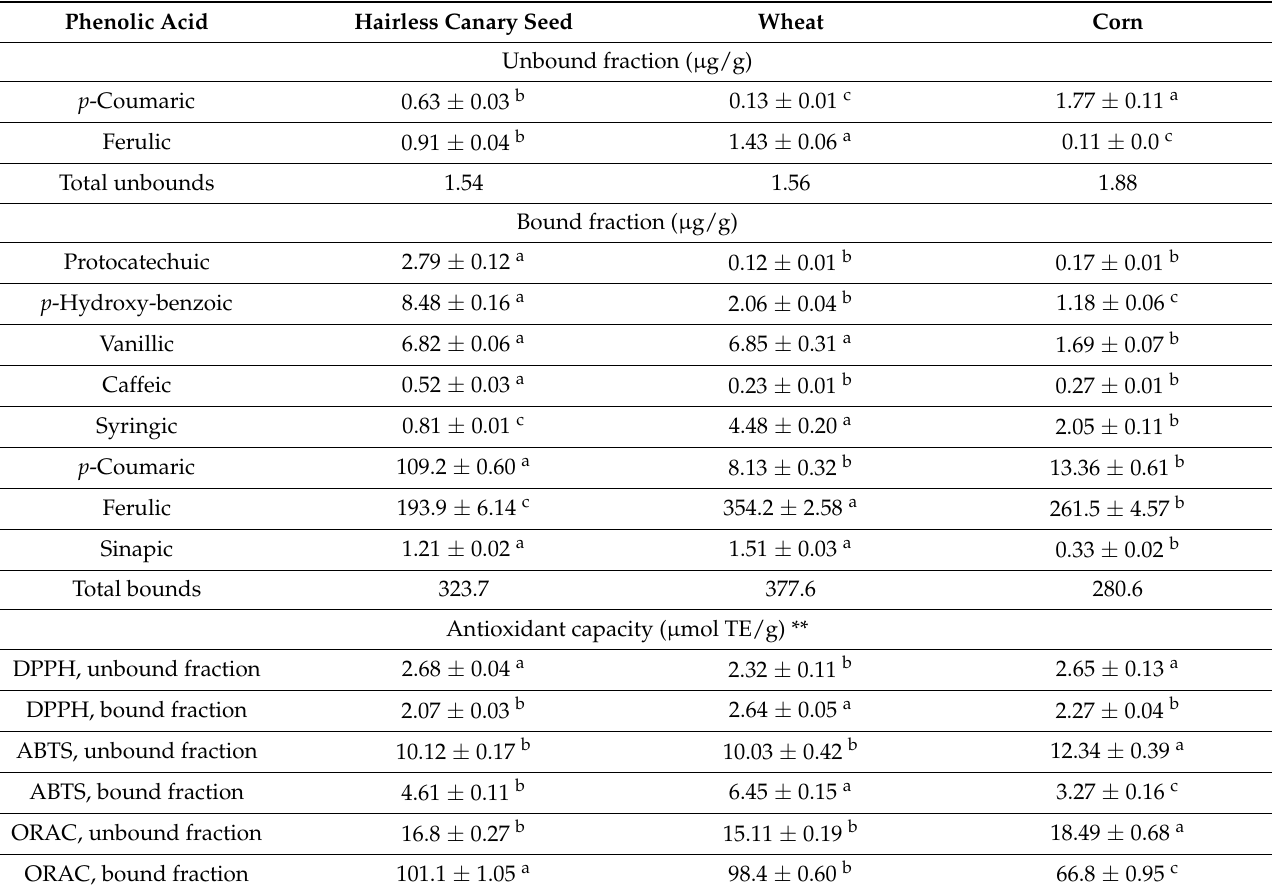
Table 1. Composition of unbound and bound phenolic acids from hairless canary seed, wheat, and corn raw ingredients and their antioxidant properties (mean ± SD) x